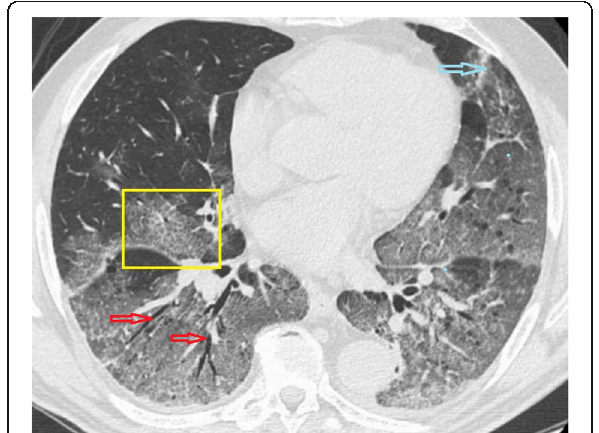
Fig. 4 CT scan of COVID-19 patient shows reticular pattern superimposed on the background of GGO with crazy paving stones signs at anterior segment of right lower lobe (yellow box), bronchiolar dilatation (red arrows) at right lower lobe, fibrotic changes (blue arrow) are also